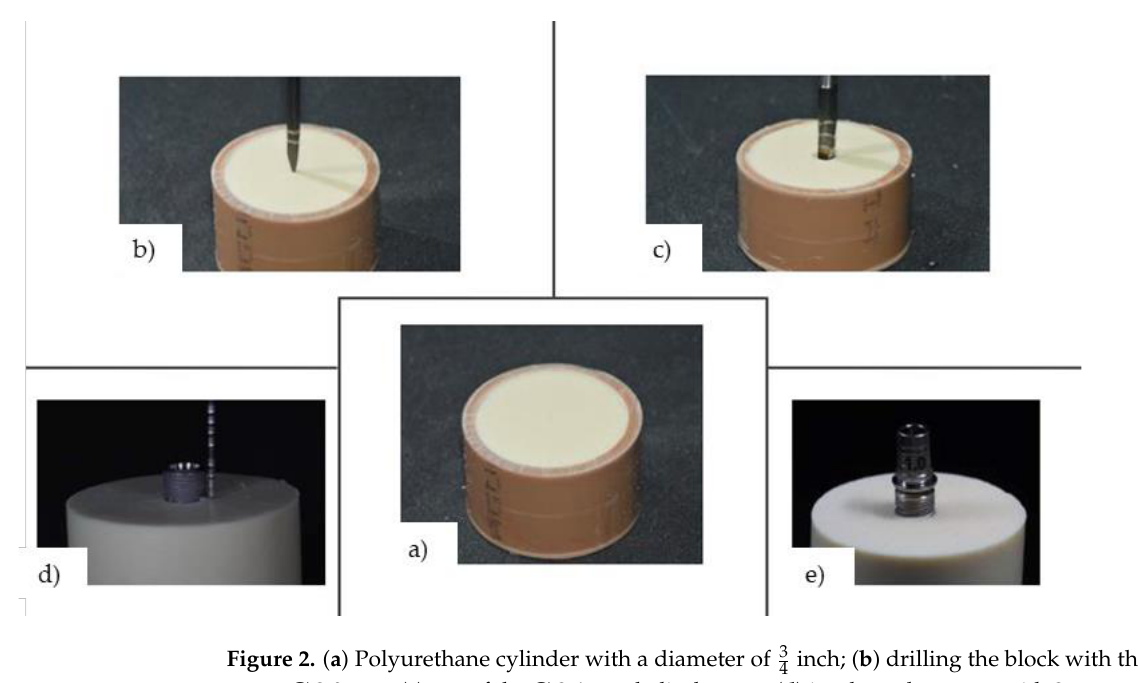
Figure 2. ( a ) Polyurethane cylinder with a diameter of ¾ inch; ( b ) drilling the block with the spear cutter Ø 2.0 mm; ( c ) use of the Ø 3.4 mm helical cutter; ( d ) implant placement with 3 mm exposure; ( e ) implant with universal link abutment 4.5 × 1.0 mm in position.